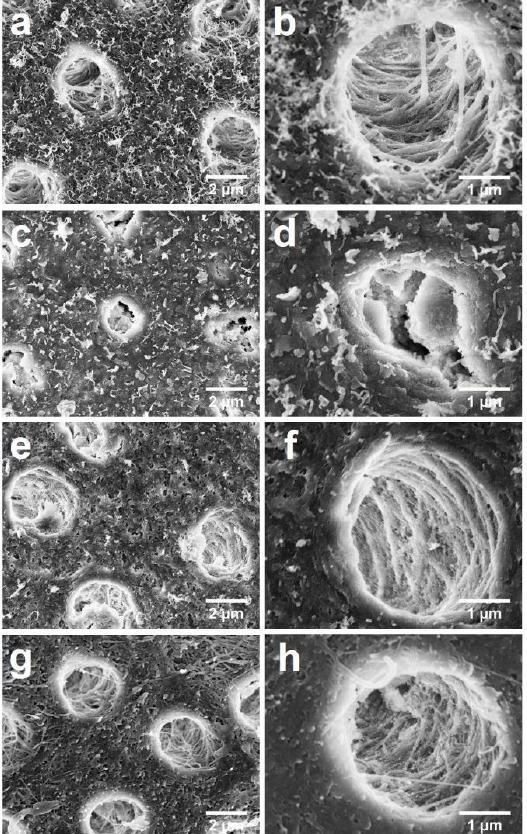
Figure 2. SEM images of the transverse section of dentine. ( a ) 8000× magnification view of Group 1 (SBAG); ( b ) 20,000× magnification view of Group 1 (SBAG); ( c ) 8000× magnification view of Group (SBAG); ( b ) 20,000 × magnification view of Group 1 (SBAG); ( c ) 8000 × magnification view of Group 2 2 (SBAG+F); ( d ) 20,000× magnification view of Group 2 (SBAG+F); ( e ) 8000× magnification view of (SBAG+F); ( d ) 20,000 × magnification view of Group 2 (SBAG+F); ( e ) 8000 × magnification view of Group 3 (F); ( f ) 20,000× magnification view of Group 3 (F); ( g ) 8000× magnification view of Group 4 Group 3 (F); ( f ) 20,000 × magnification view of Group 3 (F); ( g ) 8000 × magnification view of Group 4 (Control); and ( h ) 20,000× magnification view of Group 4 (Control). (Control); and ( h ) 20,000 × magnification view of Group 4